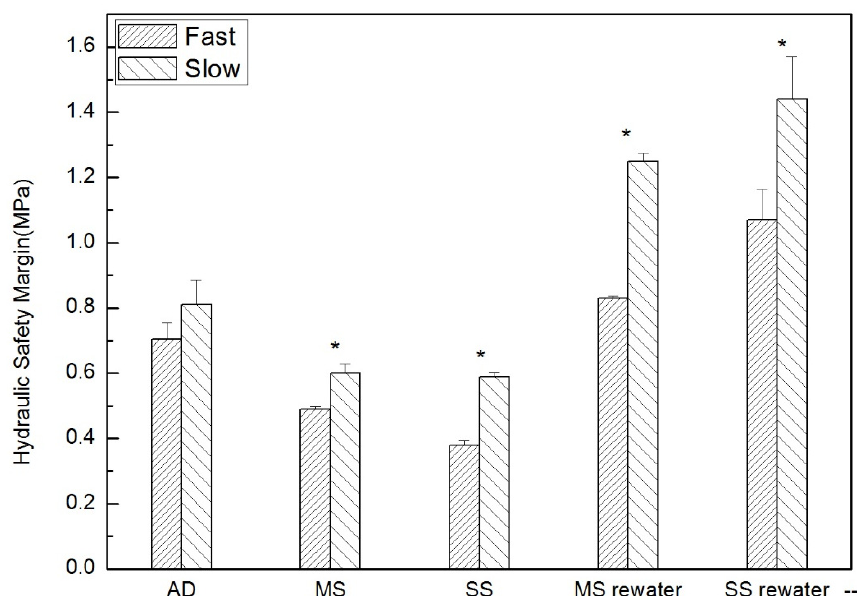
Figure 2. Comparison of the hydraulic safety margin (MPa) of the two genotypes (I-101 ( Populus alba L.) × 84K ( Populus alba L. × Populus glandulosa Uyeki)) (bars with dense line for fast-growing genotype; bars with sparse line for slow-growing genotype) under di ff erent treatment, including AD (control, absence of drought), MS (moderately water-stressed), SS (severely water-stressed), MS rewater (moderately water-stressed plants that were rewatered after drought) and SS rewater (severely water-stressed plants that were rewatered after drought). Safety margins were calculated as the minimum predawn leaf or midday branch water potential minus the stem P 50 . Asterisks (*) denote significant di ff erences between the fast and slow genotypes for treatment ( p < 0.05).